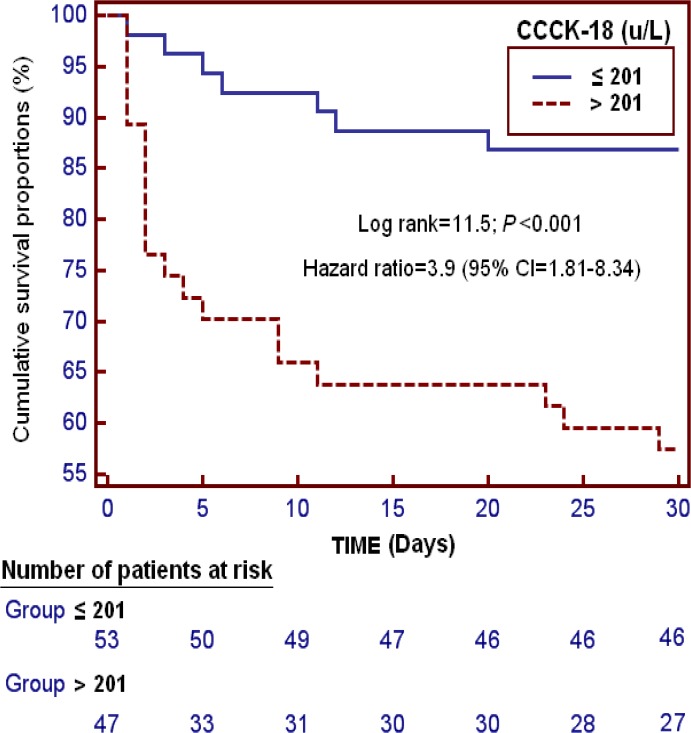
Survival curves at 30 days using serum caspase-cleaved cytokeratin (CCCK)-18 levels higher or lower than 201 u/L.